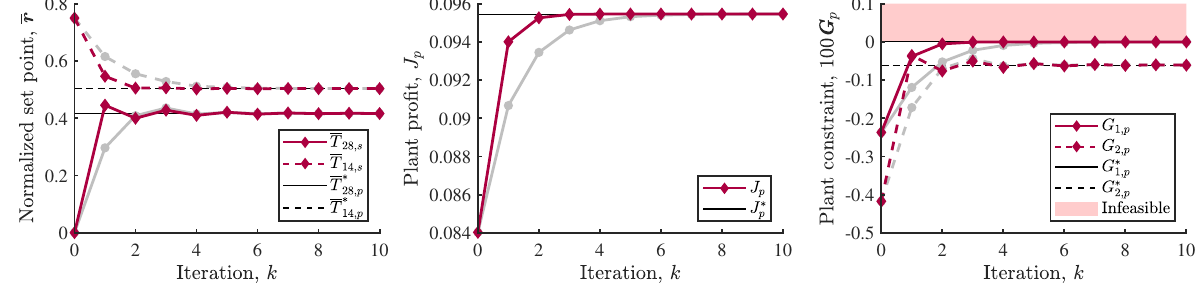
Figure 9. Distillation column RTO trajectory for MSMA using the minimum modifier solution approach shown as the red diamond line. Stable solution for standard MA is shown for comparison as the grey circle